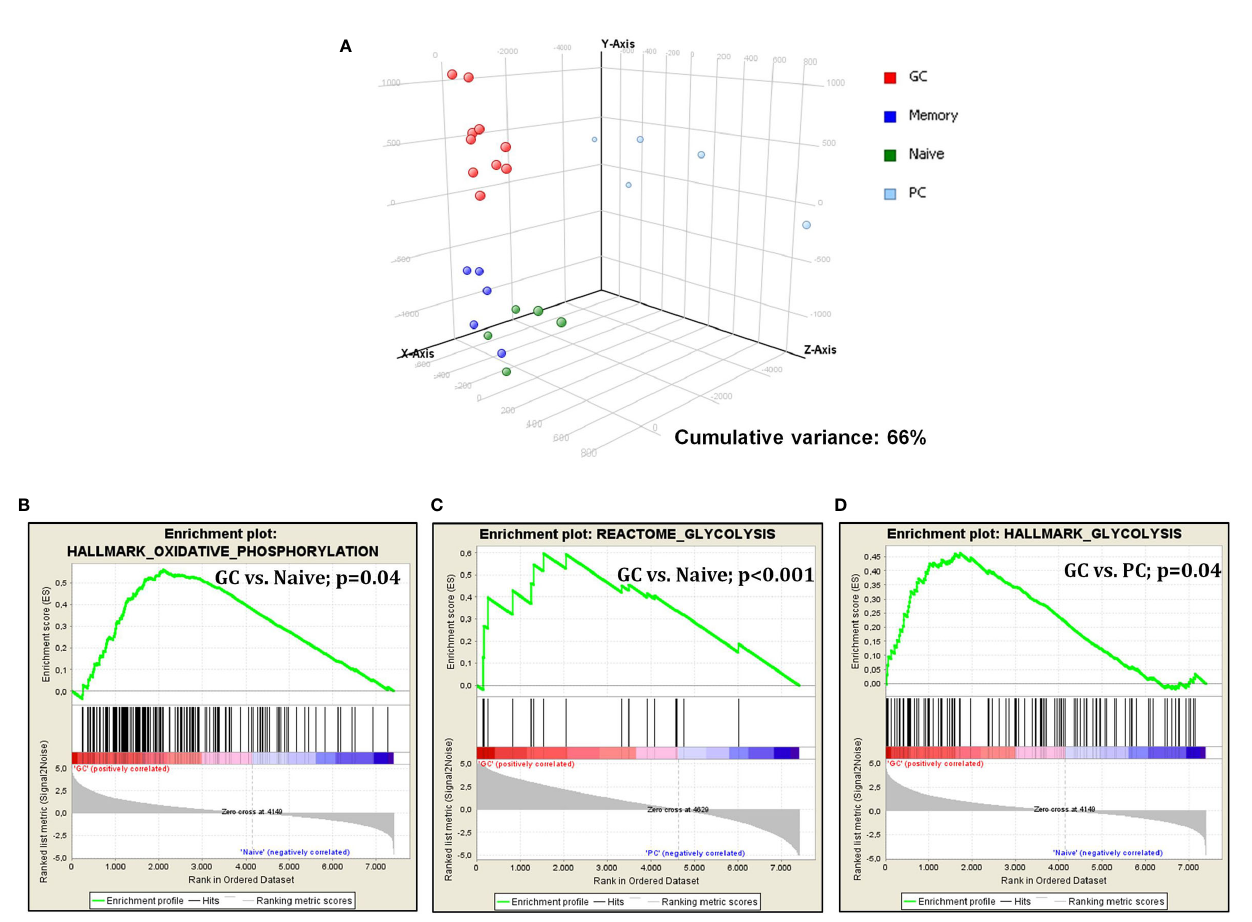
FIGURE 1 | Glucose metabolism is modulated during germinal center transition. PCA on glucose metabolism associated genes showed a clear separation among normal B-cell subpopulations (A) . GSEA showed increased expression of genes that are involved in both glycolysis and oxidative phosphorylation in GC cells vs . naive cells (B, C) and plasma cells (D)